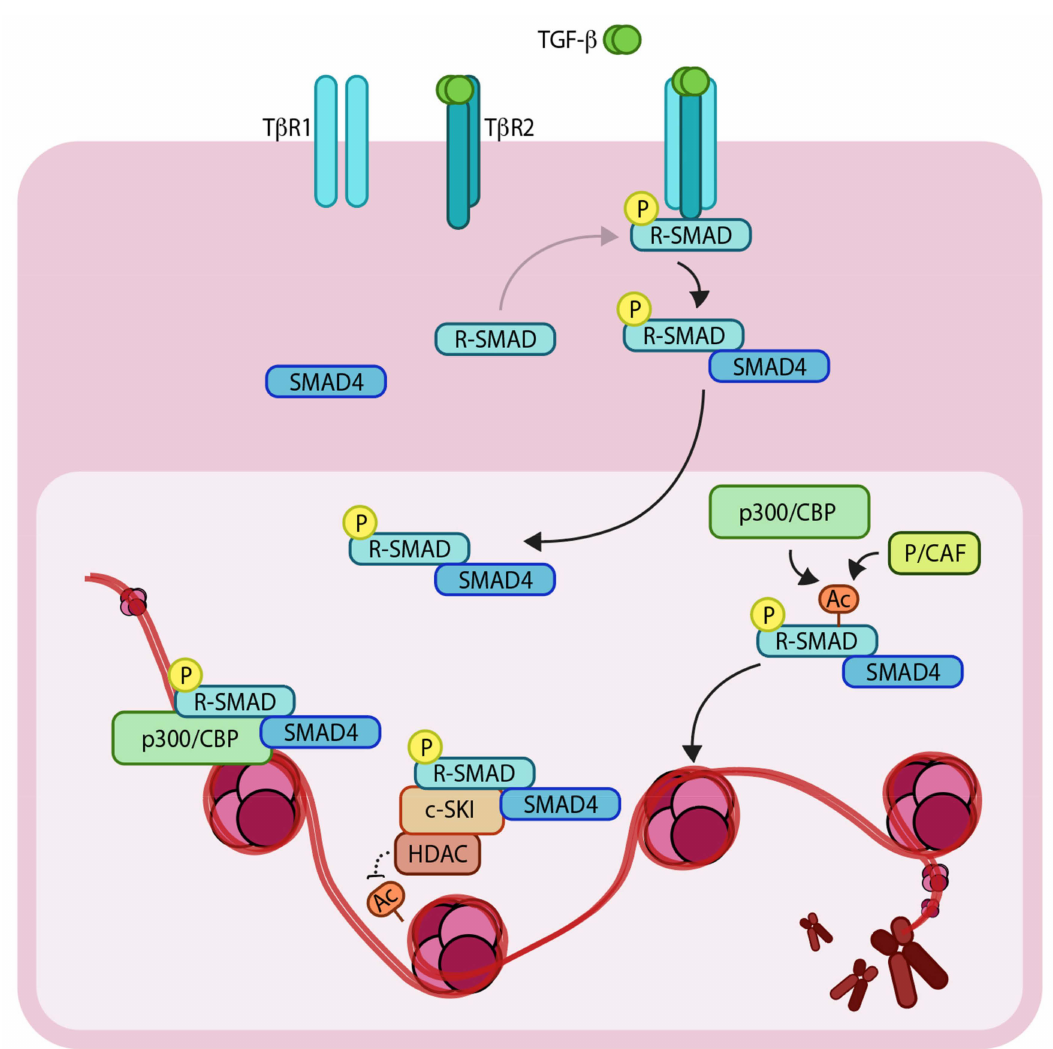
Figure 1. Schematic representation of the TGF- β (Transforming growth factor- β ) / SMAD (SMA and MAD related protein)-induced transcriptional response mediated by coactivators and corepressors. The extracellular TGF- β signals via heteromeric complex of transmembrane T β R1 and T β R2 (TGF- β receptors 1 and 2). Upon T β R1 activation, R-SMADs (Regulatory SMADs) become phosphorylated and form heteromeric complexes with SMAD4. R-SMAD / SMAD4 complexes can act as transcription factors in concert with coactivators such as p300 / CBP (CREB-binding protein) and p / CAF (p300 / CBP associated factor), as well as corepressors such as c-SKI / HDAC (Histone deacetylase). ‘P’ in yellow circles indicates phosphorylation. Arrows denote addition of a modification or transfer of a protein complex and dotted arrow represents the reverse of this. ‘Ac’ indicates